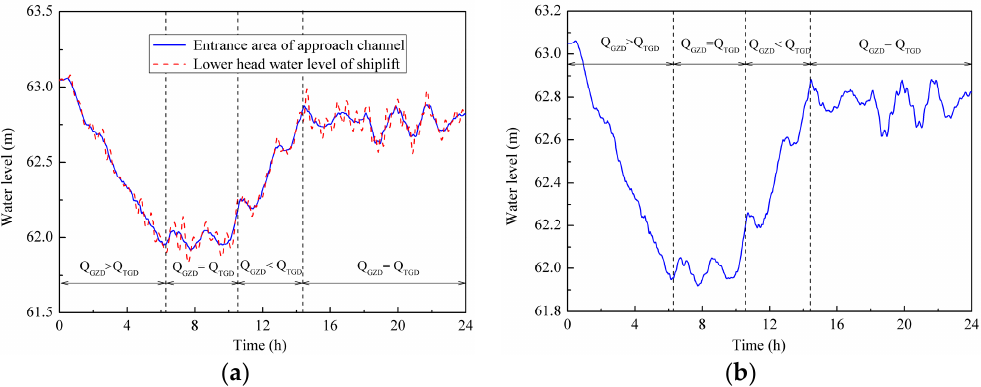
Figure 14. Water level variation process regarding single-peak regulation. ( a ) Approach channel entrance and lower lock head of the ship lift; ( b ) The planned approach channel entrance.